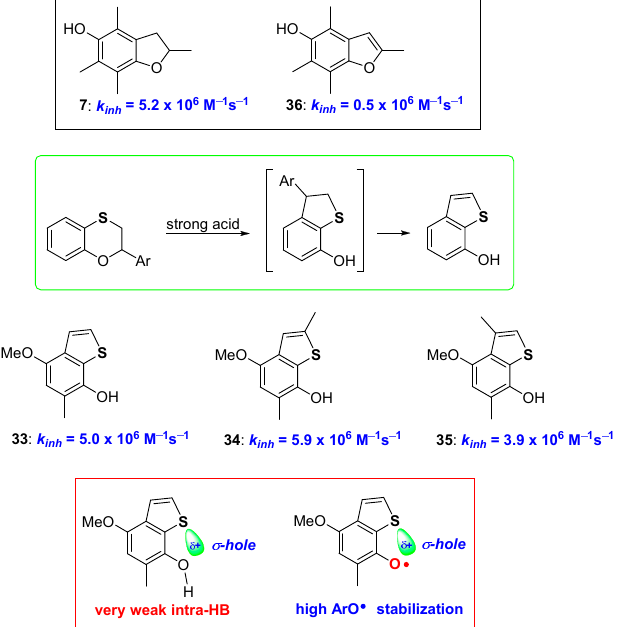
Figure 10. E ff ect of aromatization on chain breaking antioxidant activity of dihydrobenzo[ b ]furane / Figure 10. Effect of aromatization on chain breaking antioxidant activity of benzo[ b ]furane vs dihydrobenzo[ b ]thiophenes / benzo[b]thiophenes dihydrobenzo[ b ]furane/benzo[ b ]furane vs dihydrobenzo[ b ]thiophenes/benzo[b]thiophenes couples.